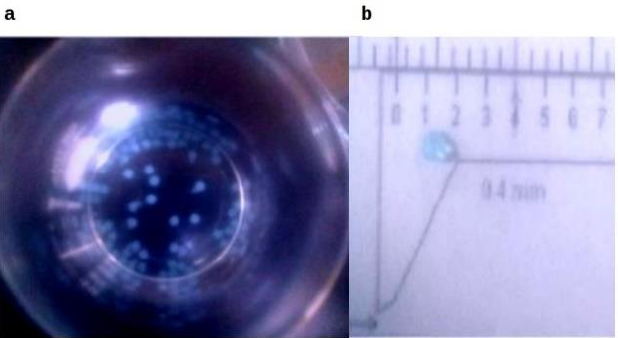
Figure 7. Copper alginate gel beads. ( a ) Photograph of the physical appearance and ( b ) size (measures approximately 1.0 mm in diameter) of immobilized Tt LacA in copper alginate gel beds synthesized.